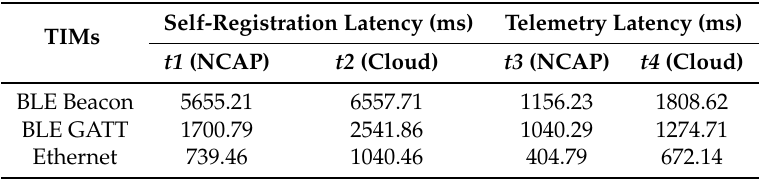
Table 3. Obtained self-registration and telemetry